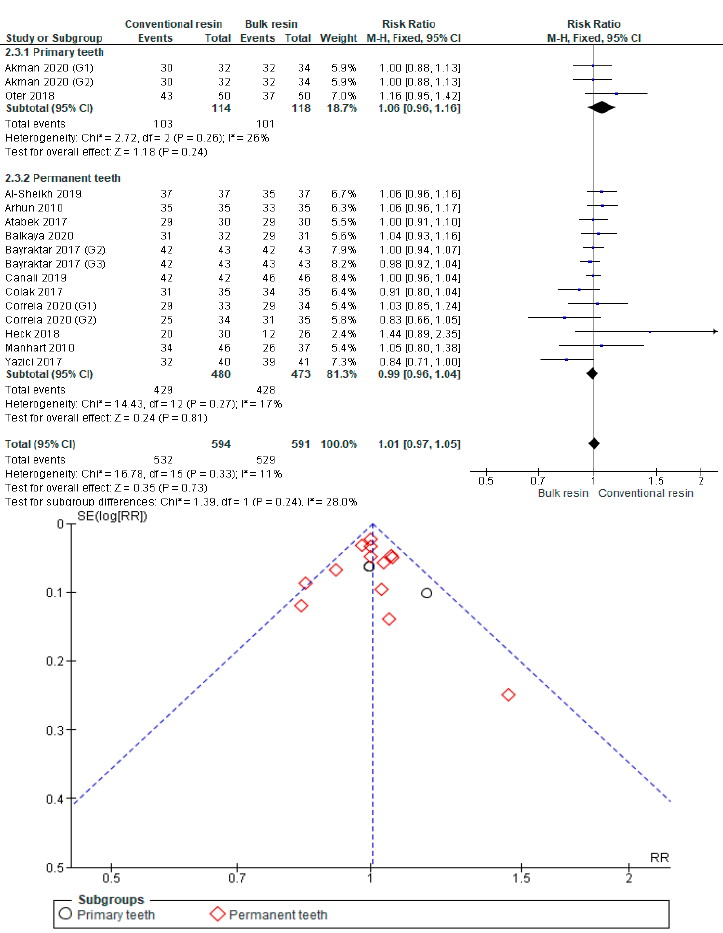
Figure A8. Absence of Discoloration or Marginal Staining: Conventional Resin versus Bulk Resin According to Type of Teething.